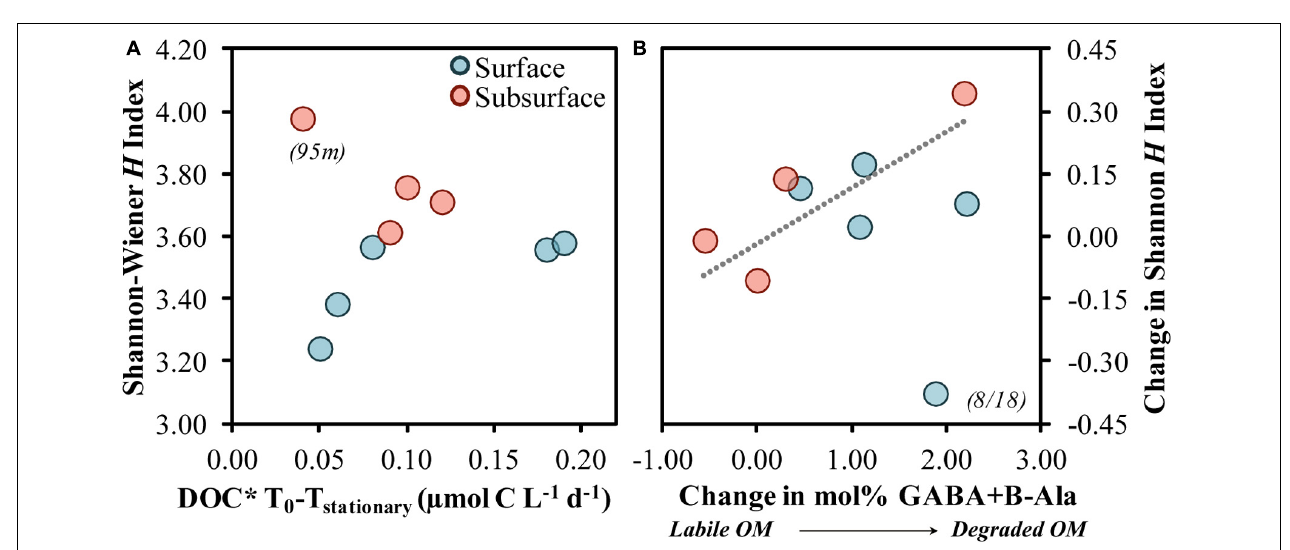
FIGURE 10 | Shannon–Wiener H index at stationary phase associated with the short-term DOC* drawdown rate from diluted experiments (A) and the change in the Shannon–Wiener H index association with the change in the THAA-based mol% GABA + B-Ala (B) . The Model II linear fit line in (B) was significant ( p = 0.029) when fit across both surface and subsurface samples but excludes the surface 8/18 sample. DOC* denotes that concentrations were corrected for bacterioplankton carbon but contain an unconstrained contribution of C < 3.0 µ